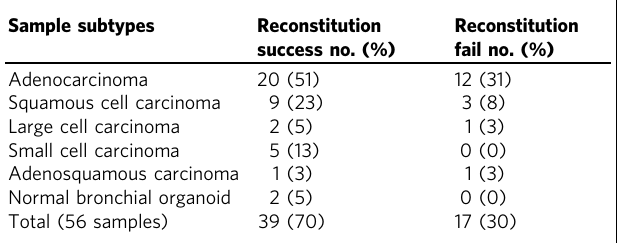
Table 3 Reconstitution of the cryopreserved organoids according to histologic subtypes Sample